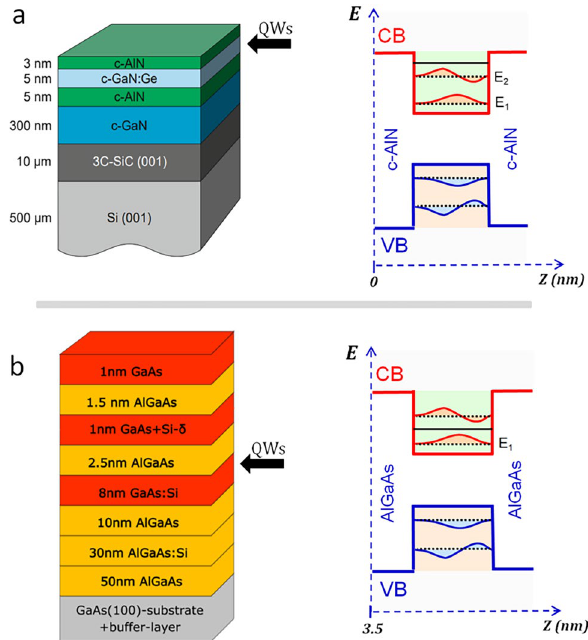
Figure 1. QW structures fabricated for the ELE-ARPES experiment. ( a ) Schematic overview of the c-GaN/ AlN heterostructure (left) and energy band diagram of the single QW including the two occupied CSB states (E 1 and E 2 ) located at z = 3 nm below the sample. ( b ) Same for the GaAs/AlGaAs QW heterostructure, showing one single occupied CSBs (E